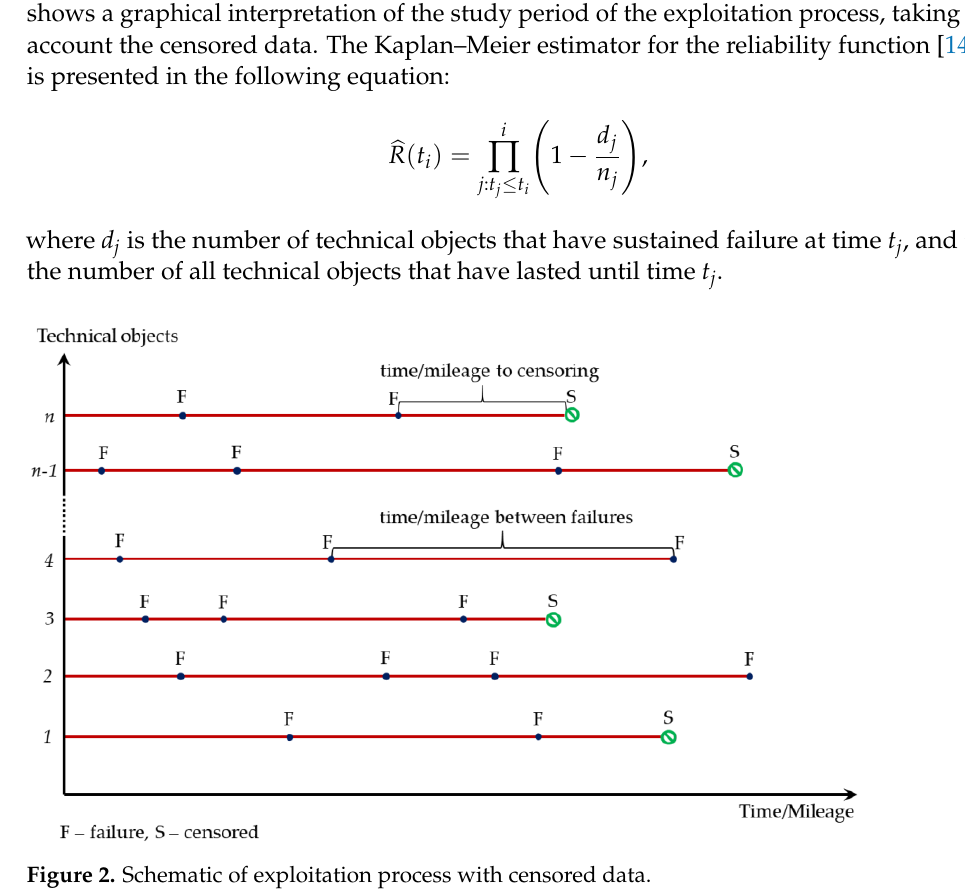
Figure 2. Schematic of exploitation process with censored data.